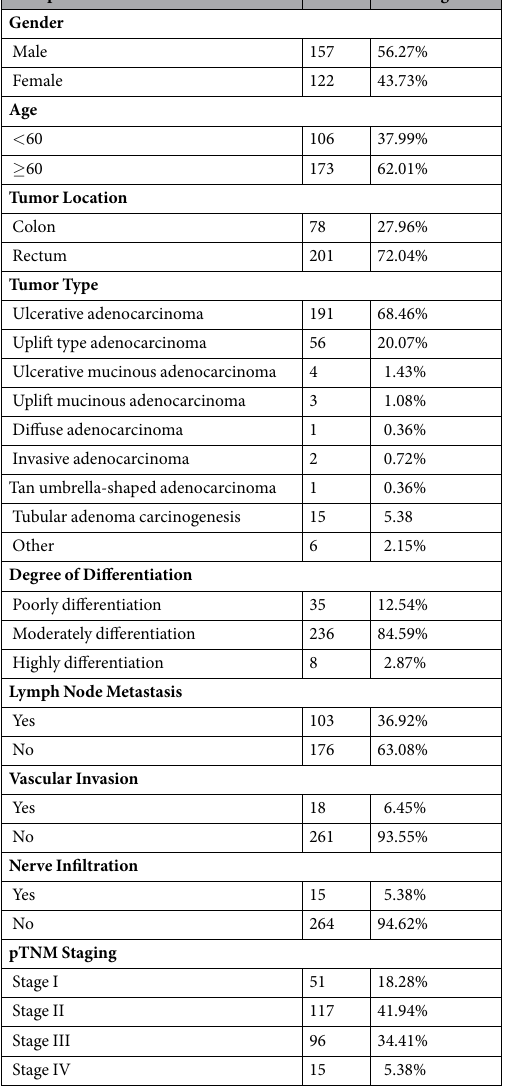
Table 4. Clinical characters of CRC patients recruited in this